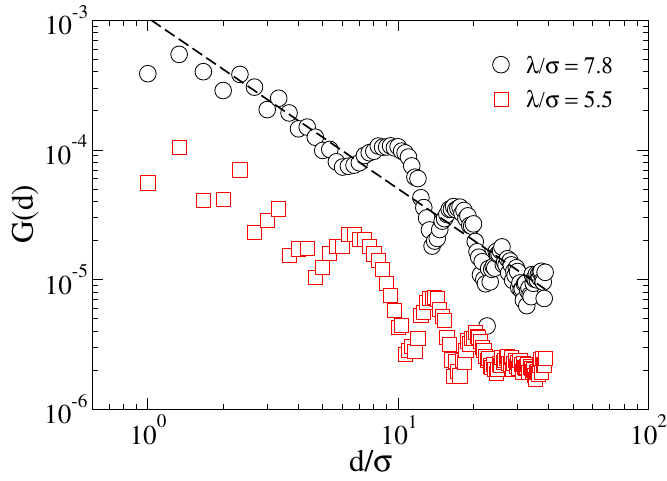
Figure 6. Spatial correlations. The correlation G ( d ) in the motion of N = 800 ( L = 80 σ , φ = 0.1) agents. G ( d ) exhibits a long-range nature, compatible with the presence of long-range excitation in a system with symmetry breaking. The oscillation superimposed to the decay of G ( d ) is due to the cellular pattern of the